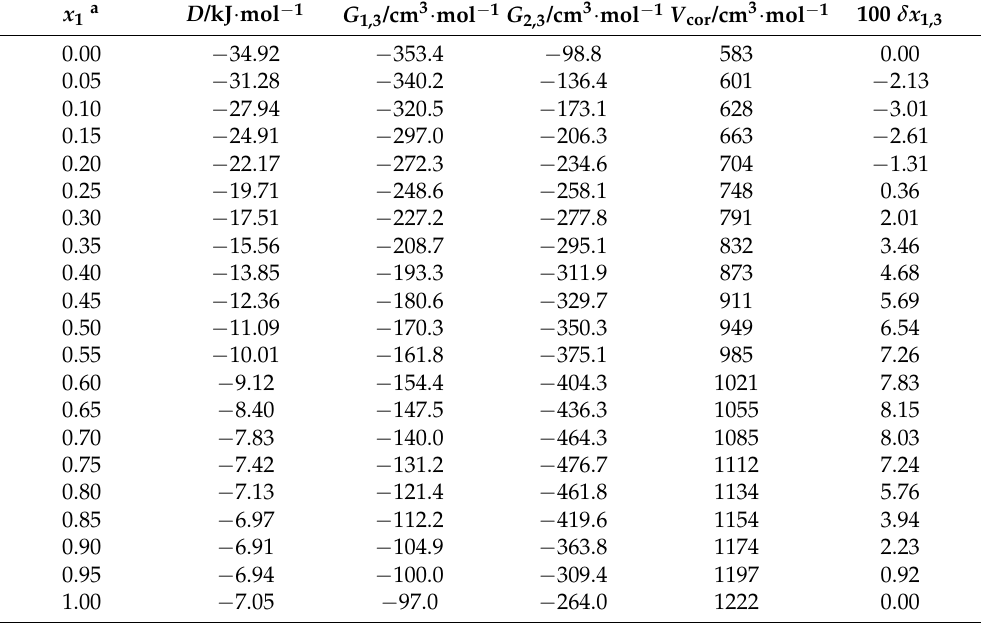
Table 8. Some properties associated to preferential solvation of benzoic acid (3) in {ethanol (1) + water (2)} mixtures at T = 298.15